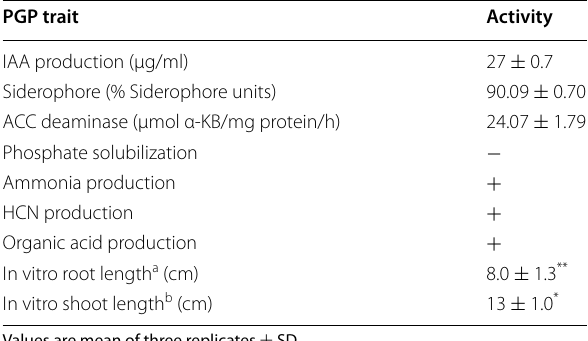
Values are mean of three replicates ns (Non-significant) indicates P > 0.05 *Significant at P ≤